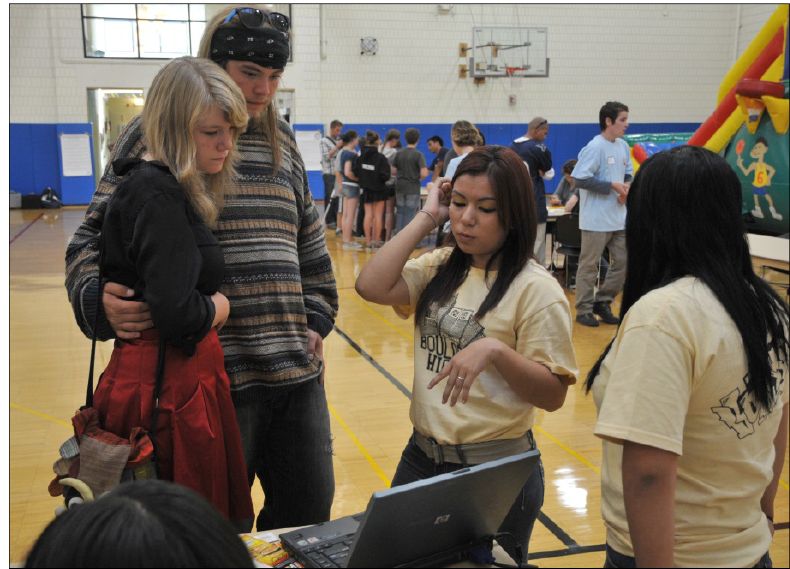
Figure 4. Two Advancement Via Individual Determination (AVID) students talking with two other high school students about a youth bill of rights at the GUB annual event (photo courtesy of Lynn M.